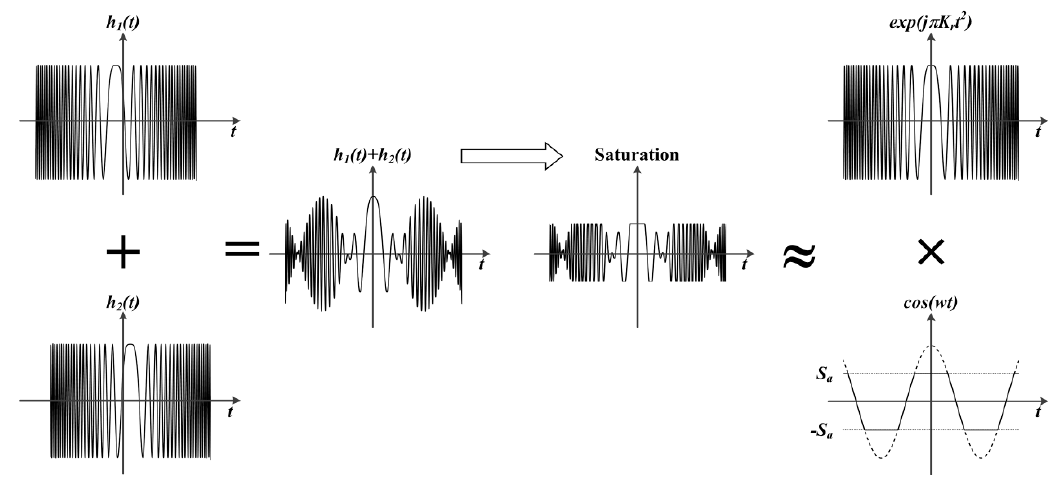
Figure 8. The decomposition of the raw data between two points. Saturation mainly affects the periodic envelope.